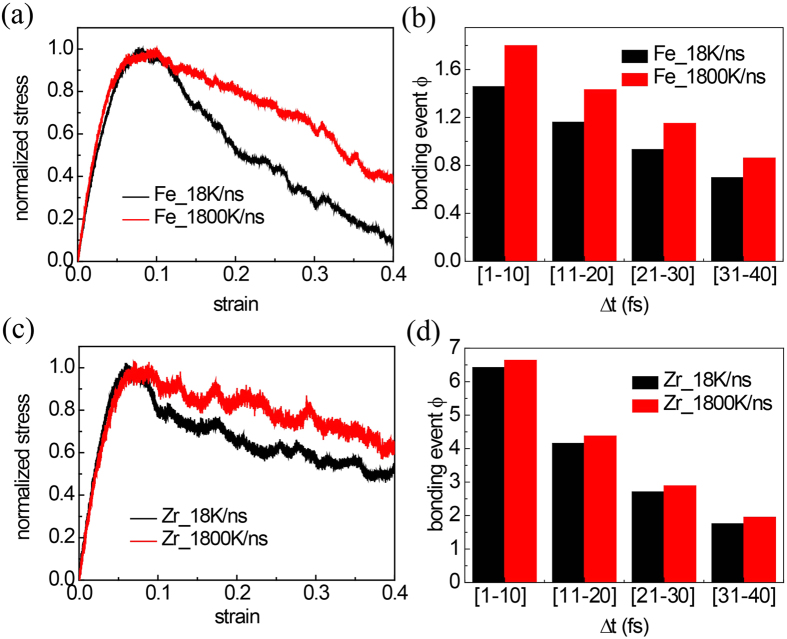
(a) Normalized stress-strain profile of P30Fe70 samples prepared at different cooling rate, and (b) the bonding event between individual FIs at different time interval of 1–10 fs, 11–20 fs, 21–30 fs etc. (c) Normalized stress-strain profile of Ni30Zr70 samples prepared at different cooling rate, and (d) the bonding event between individual FIs at different time interval of 1–10 fs, 11–20 fs, 21–30 fs etc.